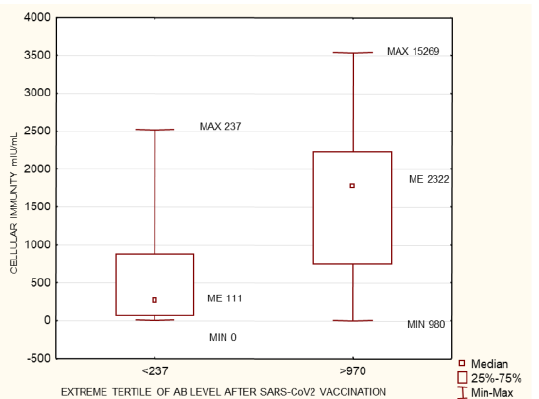
Figure 4. Statistically significant differences in cellular immunity between the extreme terciles of AB levels after SARS-CoV-2 vaccination <237 AU/mL and >970 AU/mL p = 5.66 × 10 – 08 . Mann – Whitney U test. CELLULAR IMMUNITY after completed vaccination: INFγ concentration mIU/mL, AB: antibody.